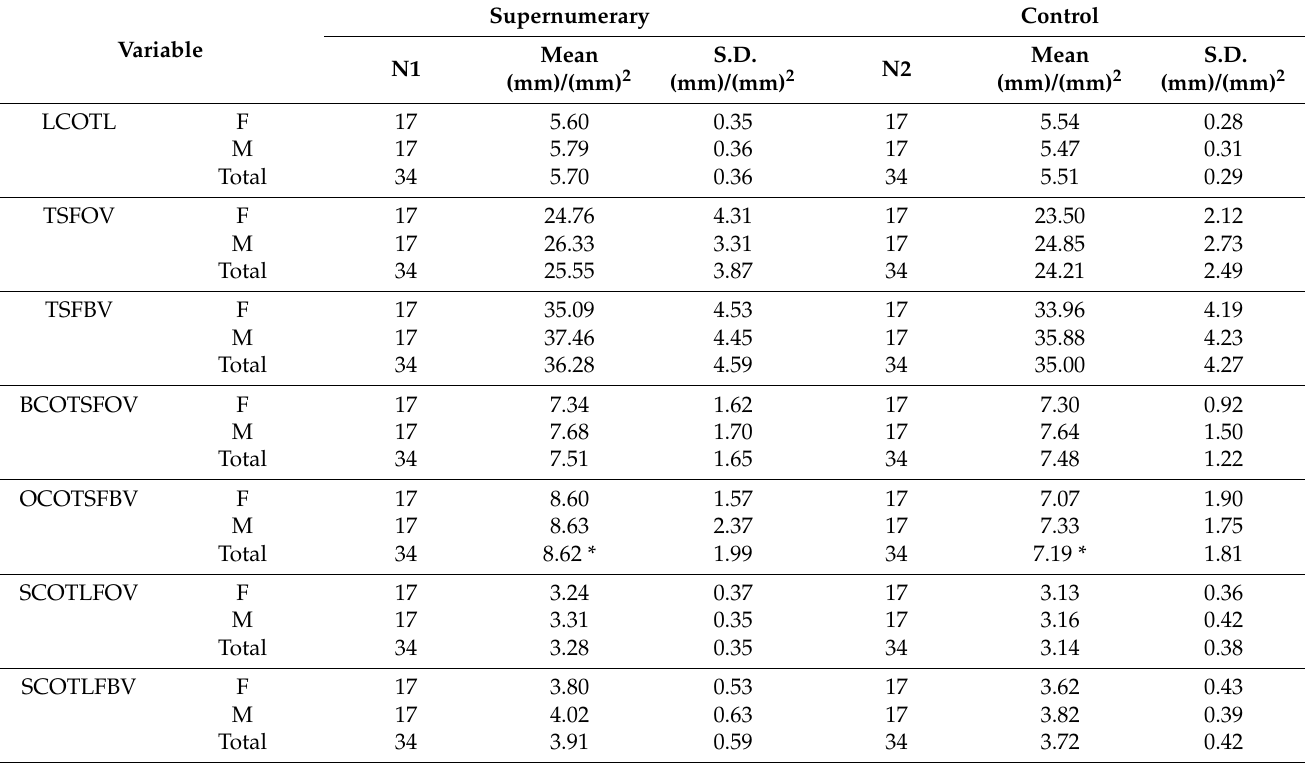
Table 5. Variables of mandibular central incisors of supernumerary and control groups.